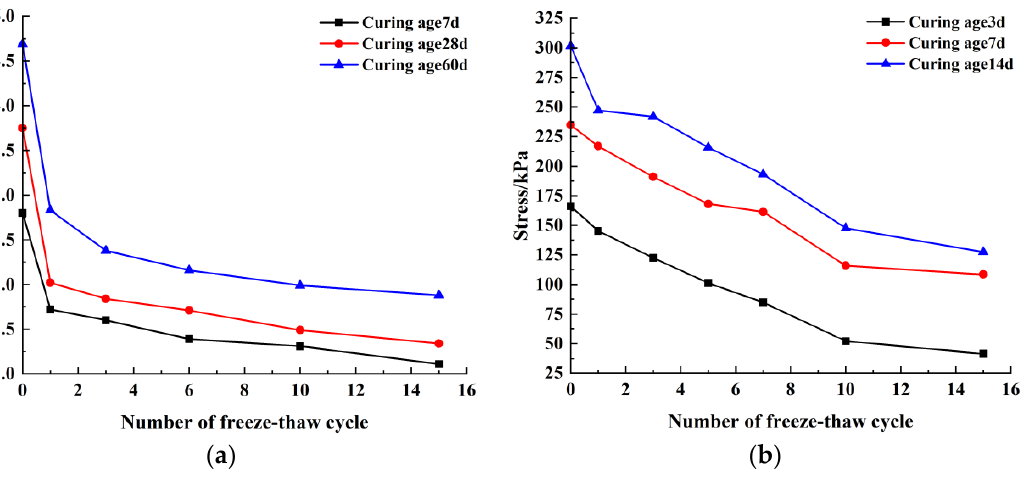
Figure 7. No water supplement during melting process: ( a ) Cement clay [21]; ( b ) Cement silty sand [22].